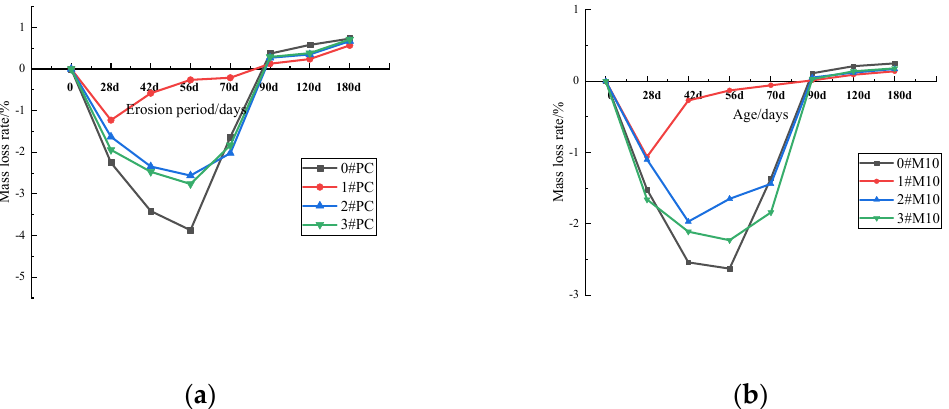
Figure 7. Mass loss rate of PC and M10 after a different erosion period under different curing conditions; ( a ) PC, ( b ) M10.